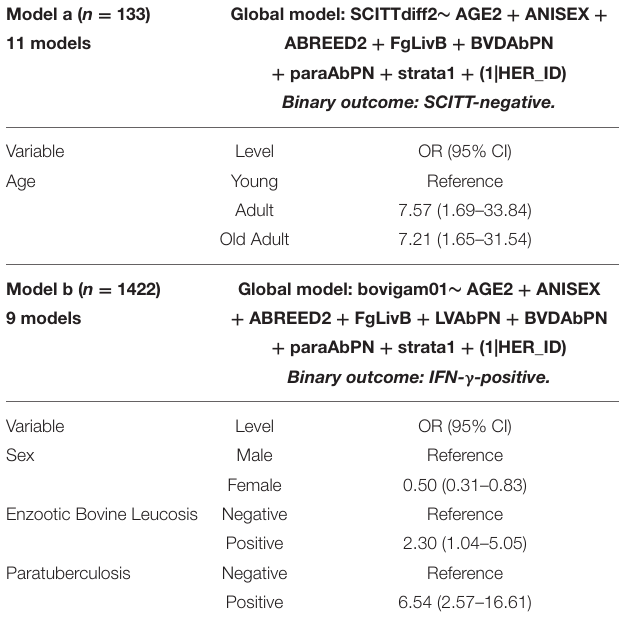
TABLE 2 | Final models to investigate risk factors for pastoral cattle testing IFN- γ assay-positive and SCITT-negative. Model a ( n = 133)